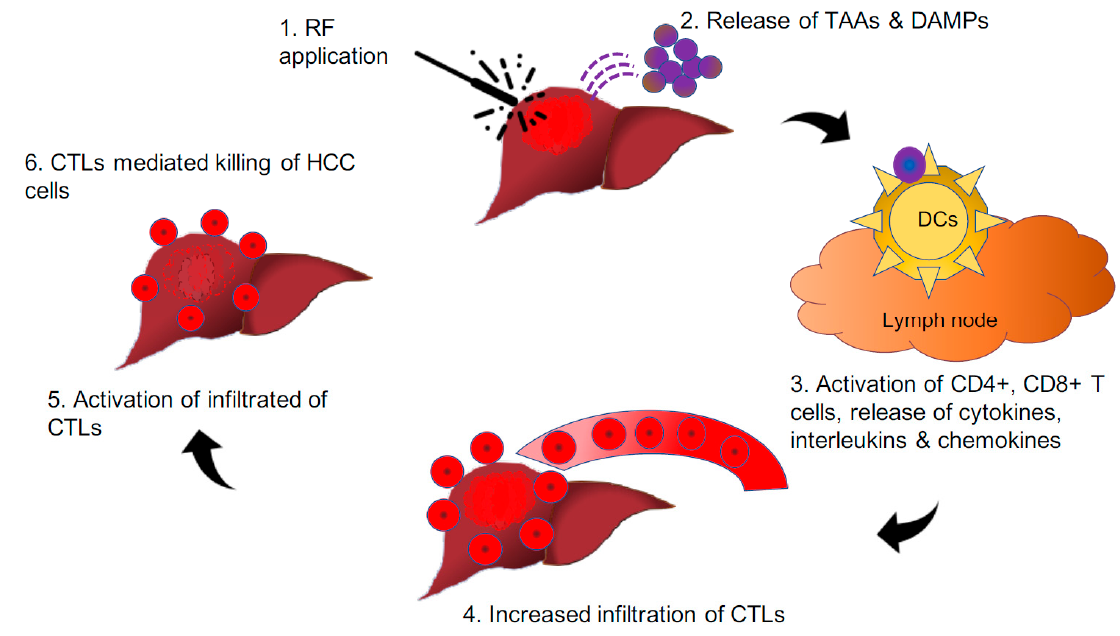
Figure 3. Pictorial depiction of the hypothesis that “in-situ vaccine effect” through radiofrequency induces the release of neoantigens and DAMPs from HCC nodules, leading to the reinstatement of the antitumour immune response.